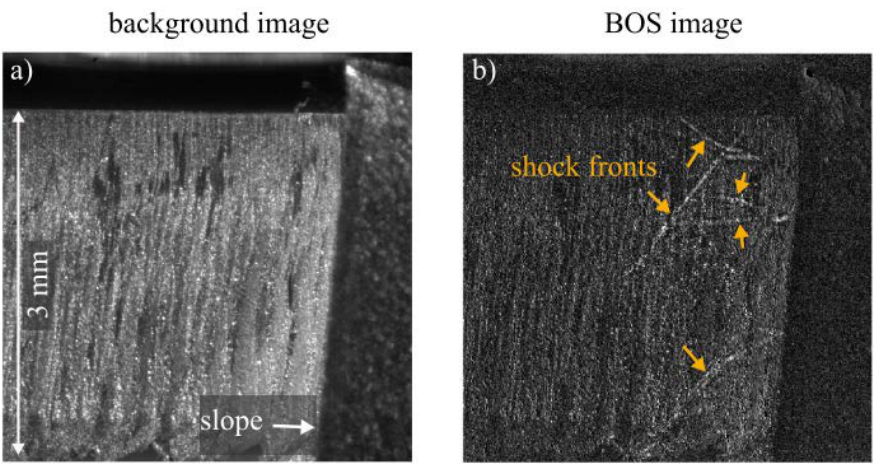
Figure 8. ( a ) background image. ( b ) BOS image of the interaction of the gas jet from the 1.8 mm diameter nozzle with the model of a cutting front, with an illumination time of 0.5 µs. The shock fronts are visible as bright lines.